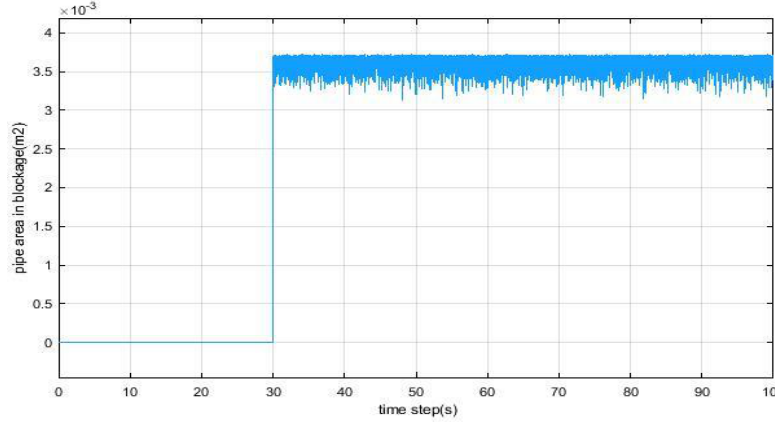
Figure 8. Pipe Cross section area in blockage.